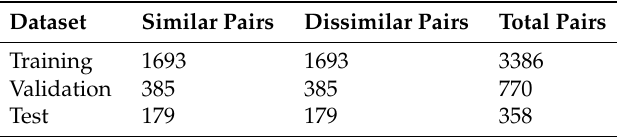
Figure 2. Examples of Visually Dissimilar Characters. Table 1. A short summary of the